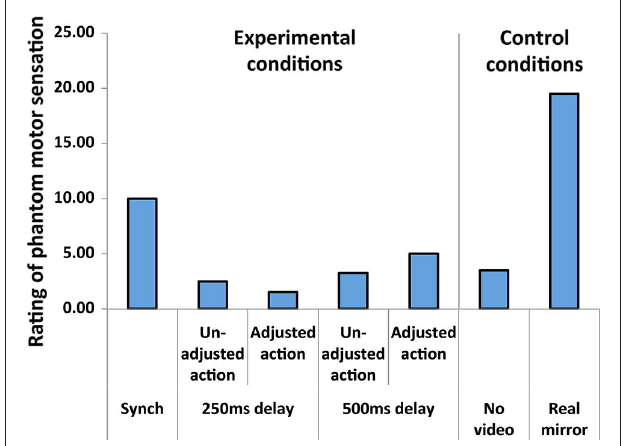
FIGURE 2 | The patient’s subjective ratings of intensity in phantom motor sensation as a function of condition